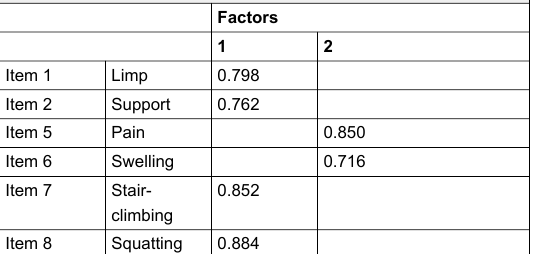
Table 6: The varimax-rotated factor matrix of the short version of the Lysholm score (factor loads <0.3 suppressed).